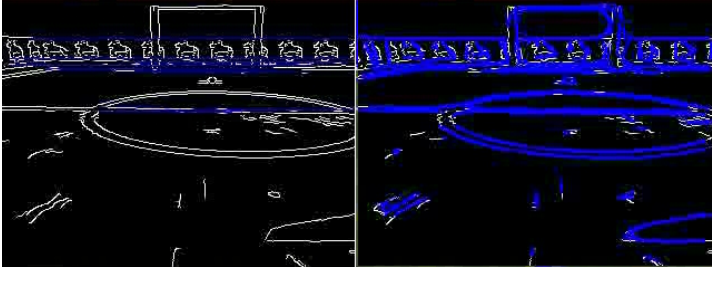
Figure 3. Differences between Canny+Hough (left) and Solis algorithm